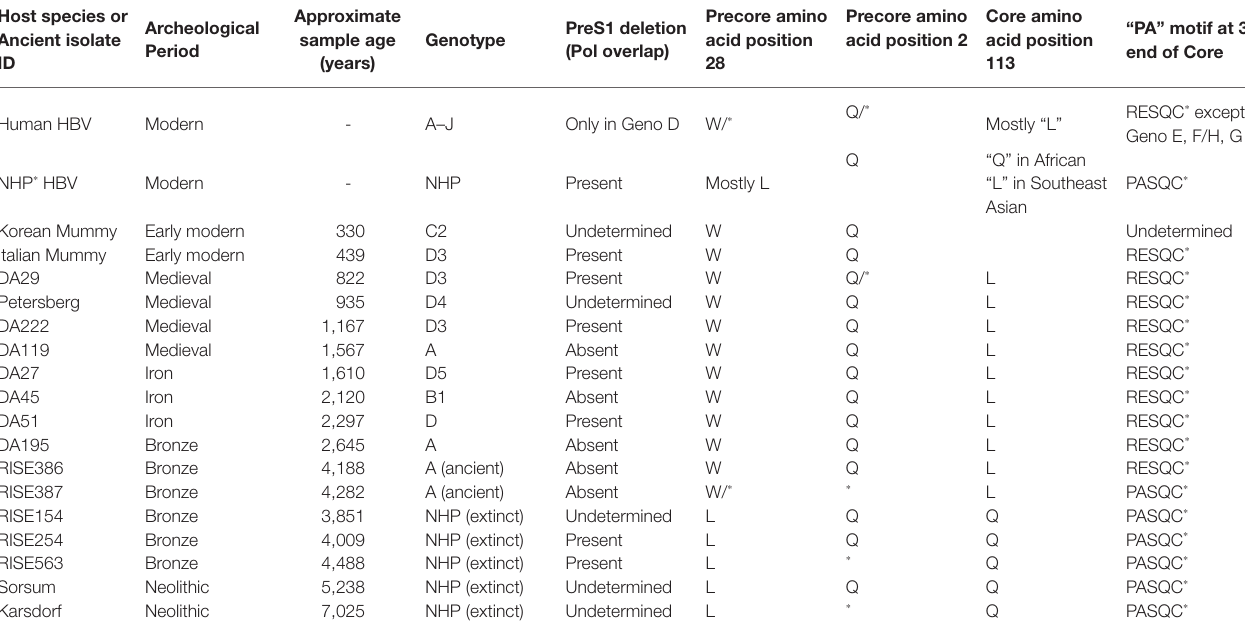
TABLE 1 | Key distinctive amino acid replacement features in non-human primate HBV sequences of aHBV compared to sequences derived from human genotypes. Host species or Ancient